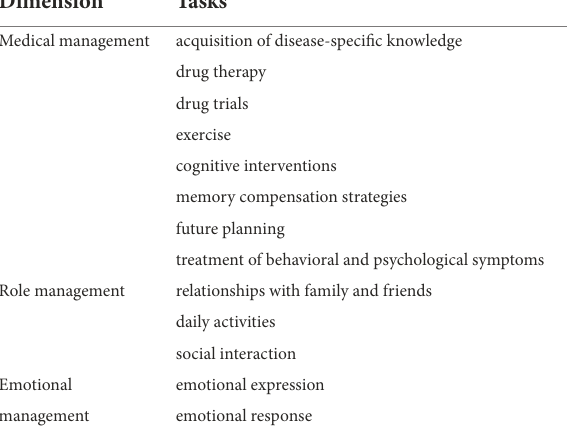
TABLE 1 A list of self-management tasks in patients with MCI. Dimension